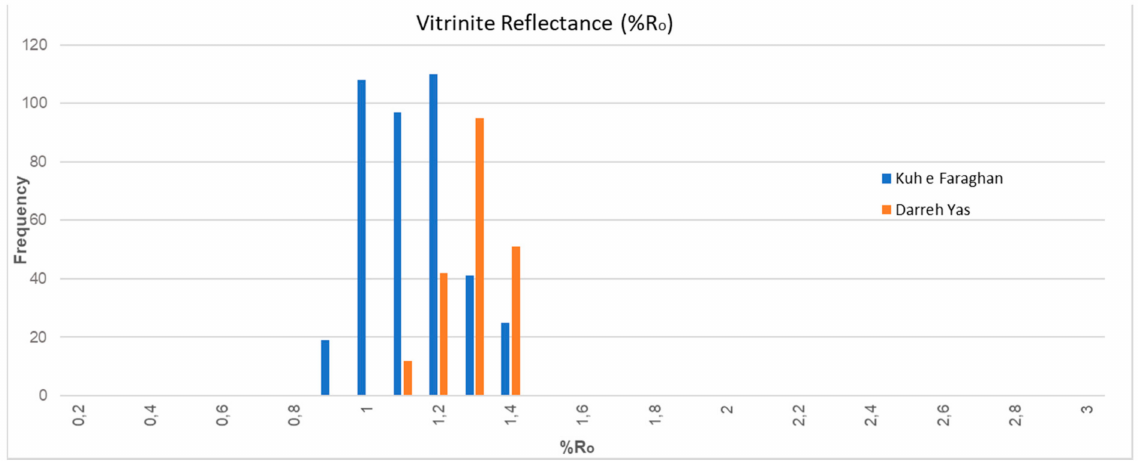
Figure 6. Histogram of %R o values of the Faraghan Formation at the Darreh Yas and Kuh e Faraghan